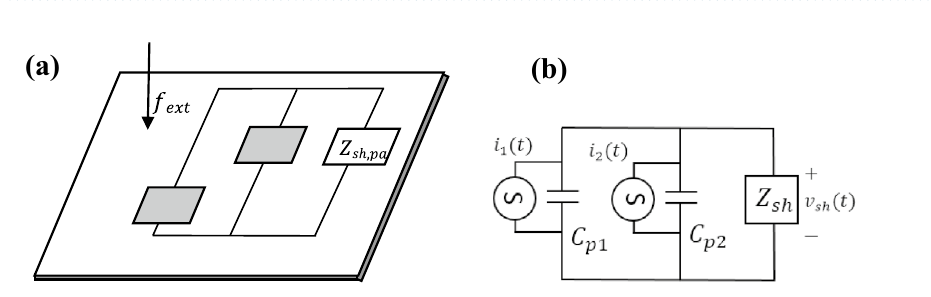
Figure 10. Schematic of two PZT patches attached on a thin plate with an external voltage applied at its terminals.